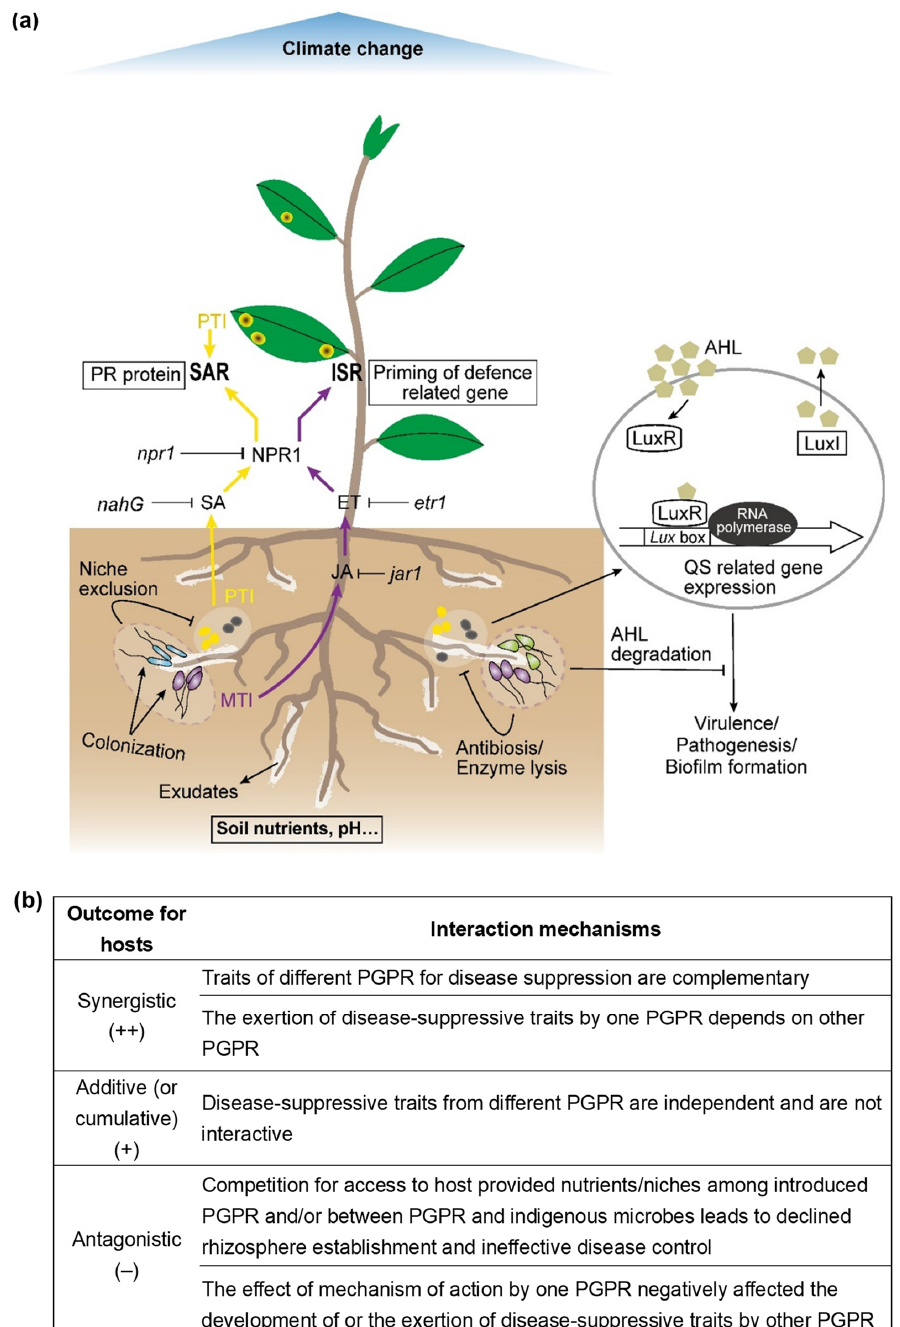
Figure 1. ( a ) The introduced multi-species PGPR assemblages (represented in blue, purple, and light green) and their diverse biocontrol mechanisms in protecting plants against different pathogens (represented in dark grey and yellow or their blend) present in rhizosphere soil or aboveground plant parts. PTI/MTI, pathogen-/microbe-triggered immunity; QS, quorum sensing; AHL, N-acylhomoserine lactone; SA, salicylic acid; JA, jasmonic acid; ET, ethylene; SAR, systemic acquired resistance; ISR, induced systemic resistance; NPR, nonexpresser of pathogenesis-related (PR) genes; LuxI, AHL synthase; LuxR, AHL regulator. ( b ) This table describes a set of interaction mechanisms between PGPR that could create the likely outcomes (synergistic, additive, or antagonistic) for the host plants.